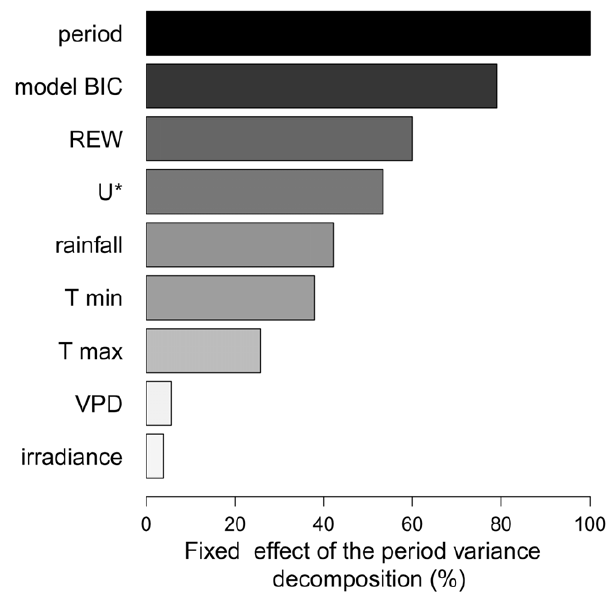
Figure 3. Ranking climate variables according to their effects on diameter growth of 205 trees from 54 neotropical species. The period effect represent 9% of the variance of tree growth. Note that (i) the model BIC catches more than 80% of the period effect and (ii) the water availability ( REW ) alone captures 60% of the period effect, respectively 7.1 and 5.4% of the variance of tree growth.